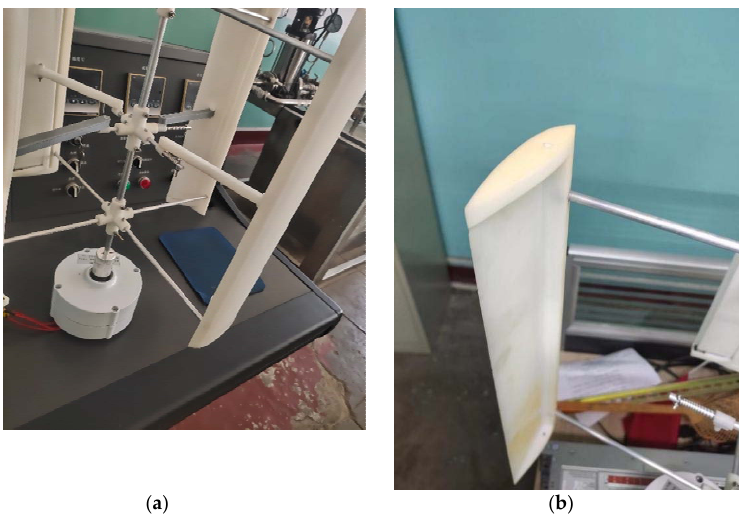
Figure 10. Physical model of wind turbine: ( a ) overall structure, ( b ) blade model.